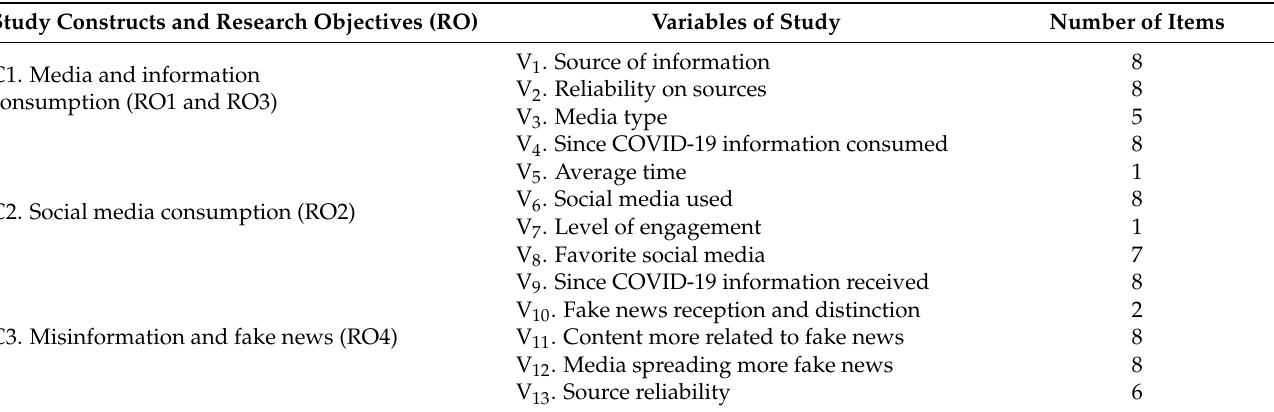
Table 1. Study constructs, variables, and number of items. Own